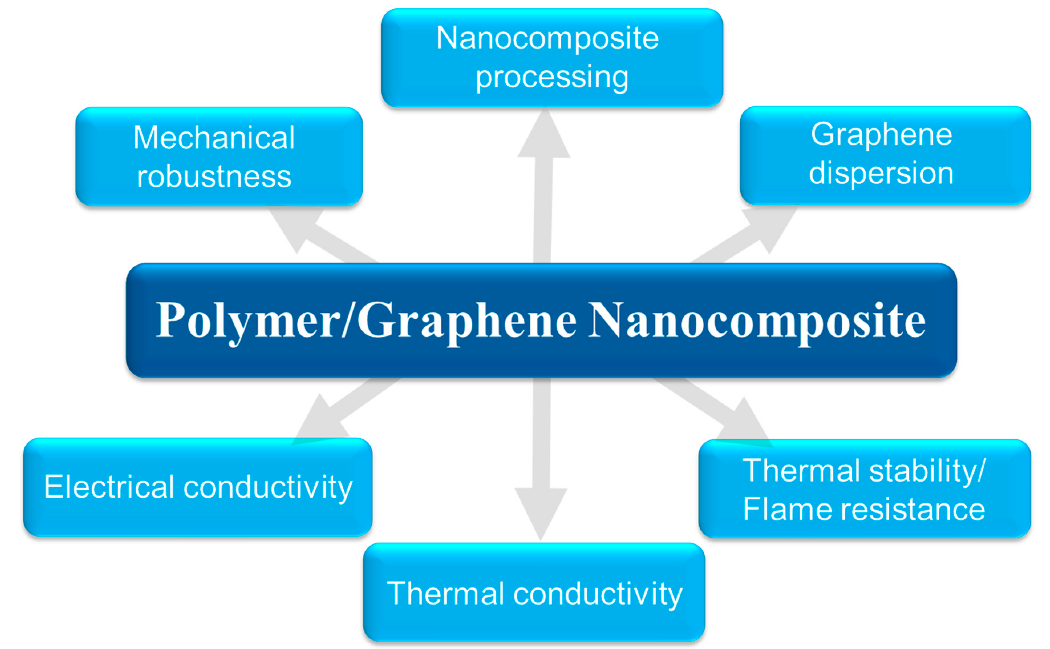
Figure 2. Properties of polymer–graphene nanocomposite.